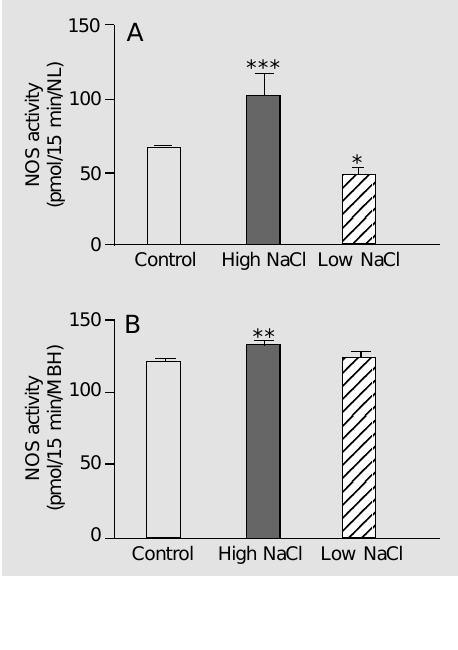
Figure 2. Effect of isotonic (0.15 M NaCl) (A) or hypertonic (0.3 M NaCl) (B) blood volume expan- sion (BVE; intrajugular injection of 2 ml/100 g body weight, over 1 min) on plasma nitrate con- centration before (control group), 5 and 15 min after BVE. Data are reported as means ± SEM for 7-10 rats. *P<0.001 compared to control (Student t - test).